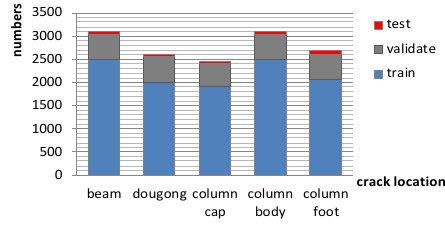
Figure 7. Dataset usage